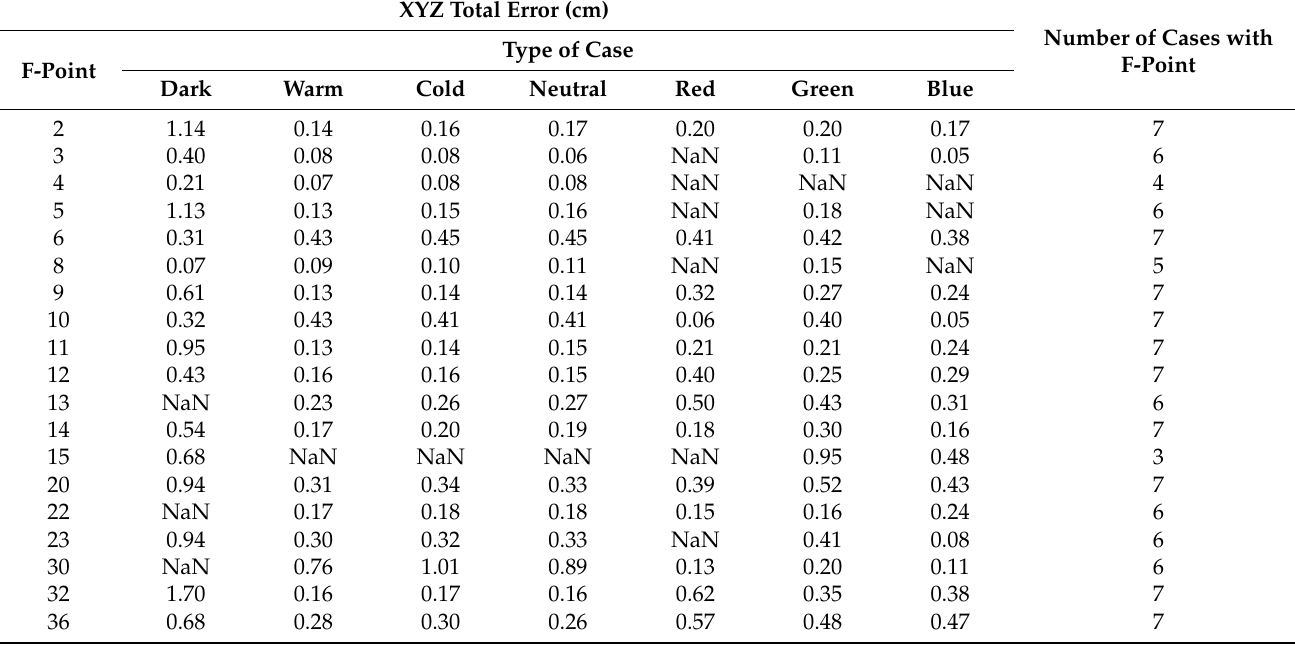
Table 5. XYZ total error values depending on the F-point and study